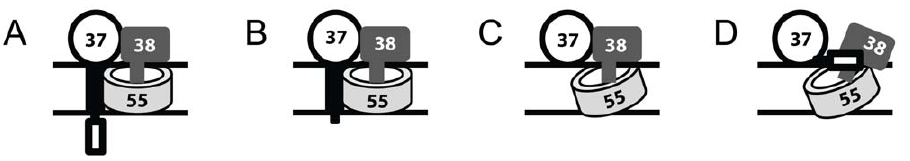
Figure 8. Hypothetical model for effects of Tob37 alterations on the TOB complex. Tob55 is shown as a pore-containing light grey ring embedded in the membrane. Tob37, is represented as in Fig. 5F with TMD1 and CHD in the outer membrane and intermembrane space, respectively. Tob38 is shown in dark grey with a domain extending into the pore of Tob55. A. The normal TOB complex. B. CHD absent. Loss of CHD has no effect on porin assembly and mild effects on Tom40 assembly. All members of the complex are shown in their normal configuration C. TMD1 and CHD absent. This results in reduced accumulation of the porin precursor at the TOB complex. Effects on Tom40 are mild. A conformational change in Tob55 is shown as one possible effect caused by loss of TMD1 resulting in porin assembly defects. D. Only TMD1 absent. This results in reduced accumulation of both porin and Tom40 precursors at the TOB complex. The conformational change in Tob55 due to lack of TMD1 is shown as in C. However, an additional change due to the suggested mislocalization of the CHD, is represented as an effect on